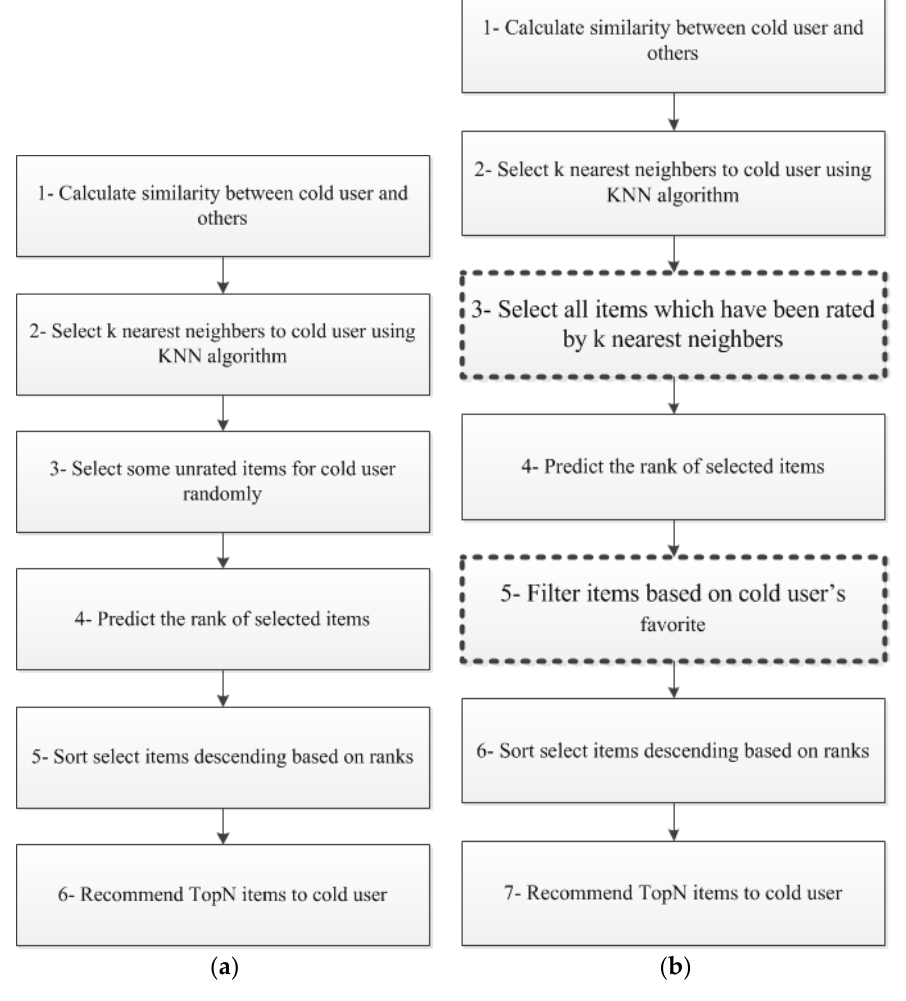
Figure 1. ( a ) Block diagram of a recommender system; ( b ) Block diagram of the proposed recommender system for cold users.